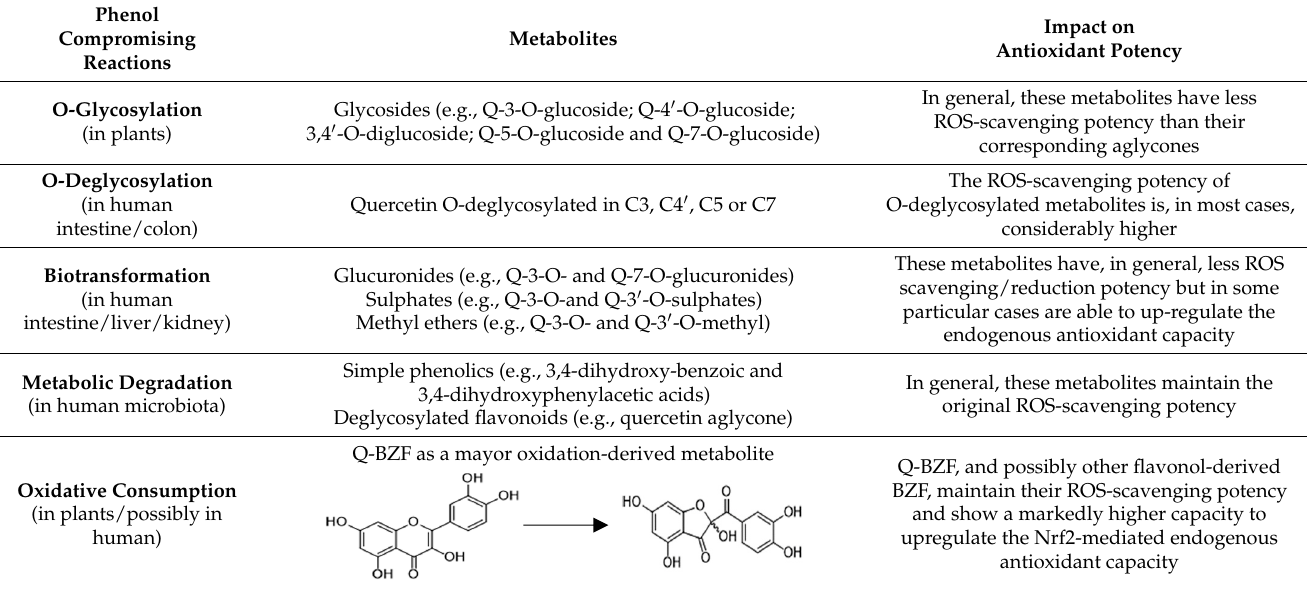
Table 1. Phenol-compromising reactions. As exemplified for quercetin (Q), the main reactions that affect the redox-active phenol moieties of quercetin are listed. In addition, the chemical nature of some of the formed metabolites and the impact that the phenol-compromising reactions can have on the antioxidant properties of the metabolites are described.